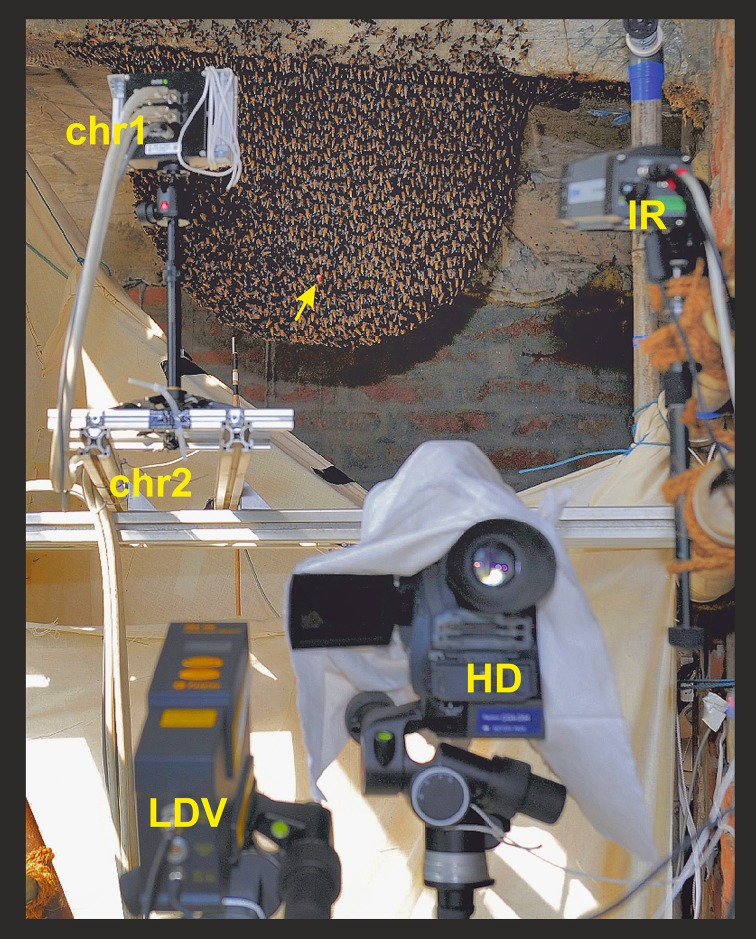
Experimental setup.The experimental Apis dorsata nest in a bay at the shaded rear side of the second floor of a hotel in Chitwan (Nepal); built at a traditional nesting site, which can be discerned by the wax traces from previous years. In front of the nest on the unsecured balcony the recording devices were placed: IR, infrared camera; HD, high definition camera; chr1 & chr2, two additional high resolution cameras for other purposes [28–31]; LDV, laser Doppler vibrometer [30]. The yellow arrow marks the spot of the red LDV light reflected at the end plane of a rod, which had been stuck through the comb (see also schematics in S3 Fig).